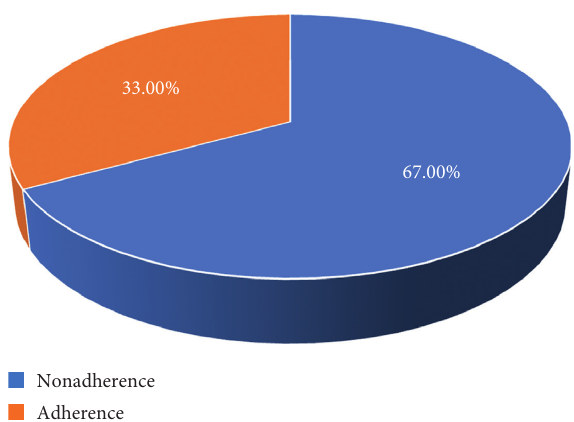
Figure 1: The level of nonadherence to self-care practices among hypertensive patients in a follow-up clinic at Asella Referral and Teaching Hospital, Asella Town, Arsi Zone, Oromia Regional State, Ethiopia, 2020 ( n � 115).